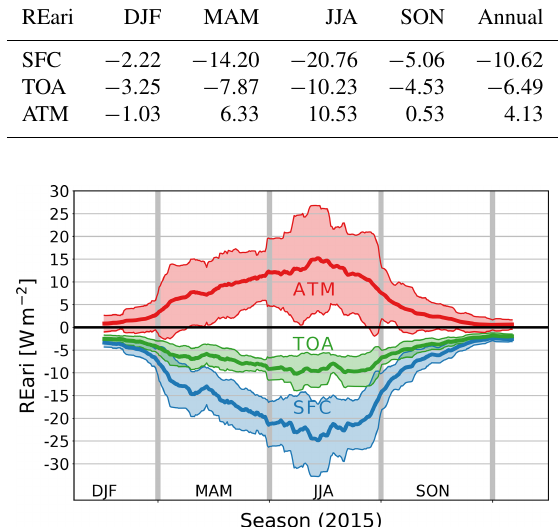
Figure 15. The 30d rolling mean of REari at the surface (SFC), top of the atmosphere (TOA) and total atmosphere (ATM) of the year 2015 simulated with T–CARS over Germany. The variability within 30d is shown by the rolling SD as shaded areas.